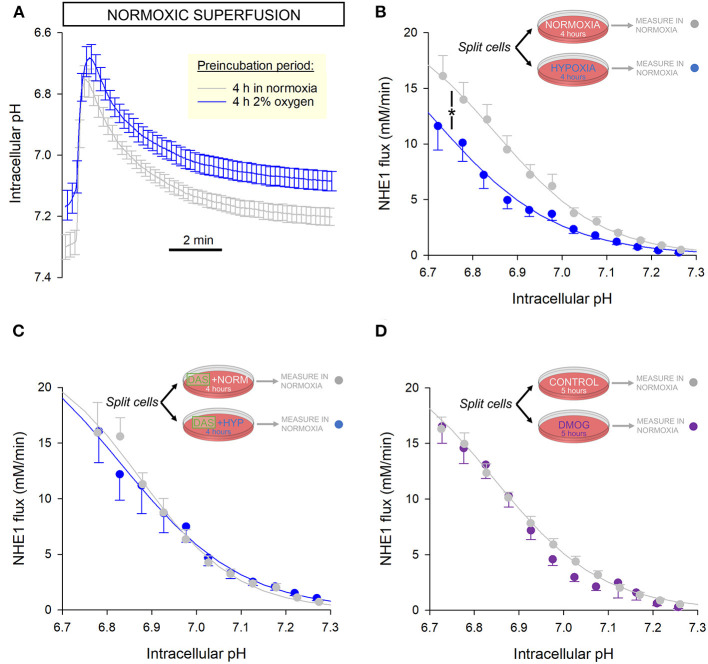
NHE1 activity is persistently inhibited following 4 h incubation in hypoxia. (A) Freshly isolated rat myocytes were split and incubated either in an atmosphere of 2% O2 or normal air. Low O2 was maintained by under an Ibidi Chamber. After incubation, NHE1 activity was measured in myocytes under normoxic superfusion, within 30 min of re-oxygenation (n = 30 control cells and 28 hypoxia-pretreated cells from 4 rats). (B) NHE1 activity remained lower in cells that had been exposed to hypoxia, indicating that the inhibitory effect of low O2 persists after re-oxygenation. Two-way ANOVA: significant effect of treatment (hypoxic pre-incubation) (P < 0.0001) and interaction between treatment and pH (P < 0.0001). (C) Experiments were repeated in the presence of 100 nM Dasatinib, a Abl/Src tyrosine kinase inhibitor. In the presence of inhibitor, hypoxia had no effect on NHE1, consistent with the role of Y561 phosphorylation (n = 15 controls cells, 16 hypoxia pre-treated cells; from 3 rats); two-way ANOVA: no significant effect of treatment (hypoxic pre-incubation) in presence of Dasatinib (DAS) (P = 0.96); no significant interaction with pH (P = 0.98). (D) 5 h treatment with 1 mM DMOG had no effect on NHE1 in rat myocytes, compared to controls (n = 34 controls cells, 27 DMOG-treated cells from 4 animals); two-way ANOVA: no significant effect of treatment (DMOG) (P = 0.78).